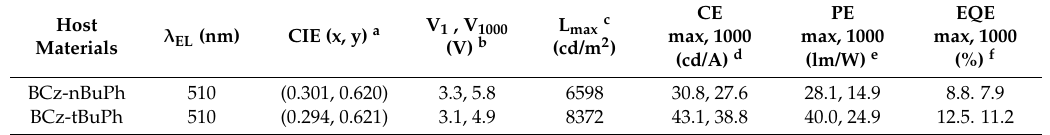
Table 2. The performance of solution-processed green PHOLEDs using BCz-nBuPh and BCz-tBuPh . Host